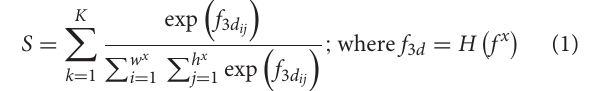
normalized to calculate the importance score (or soft attention score) based on the appropriate location from the extracted feature map. A 3-D tensor f x ∈ R h x × w x × d x having a 3-D kernel of size H ∈ 3 x 3 x n x is input to the convolutional layer that results in a feature map f 3 d ∈ R h x × w x × 1